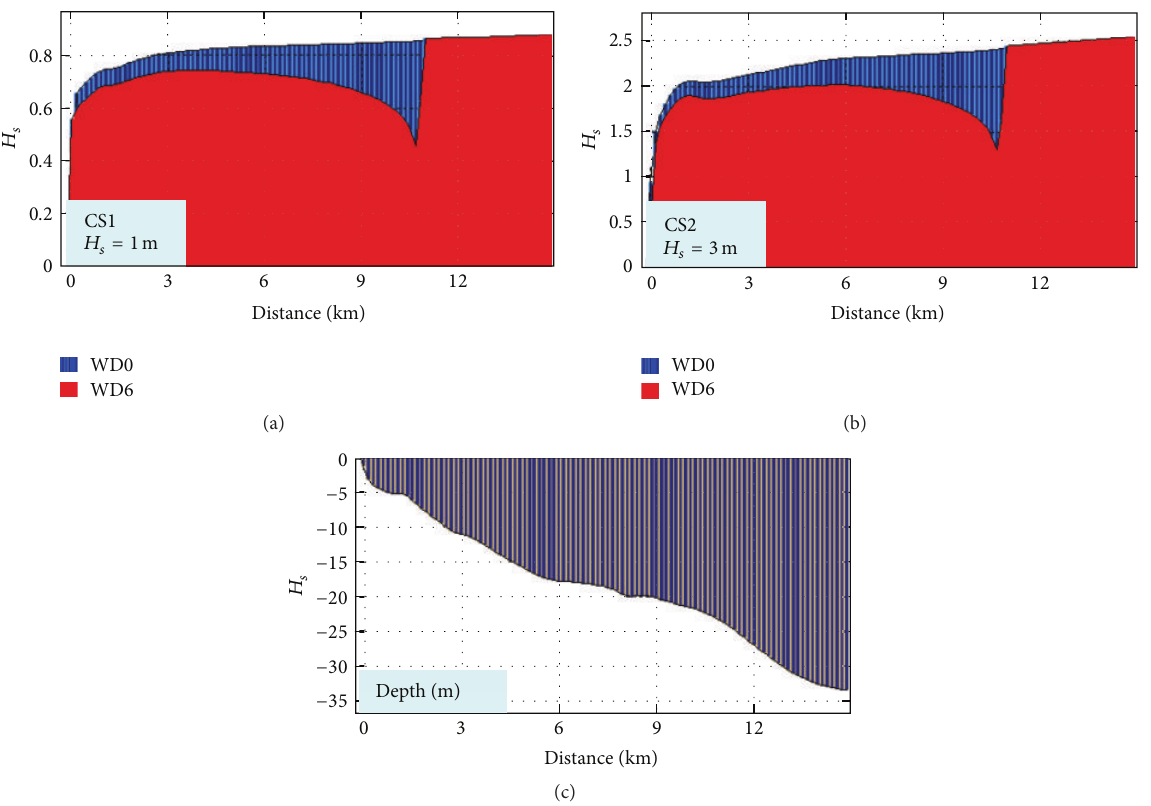
Figure 12: 𝐻 𝑠 variation along the reference line 1 without and with WD farm (WD0, WD6) for the two cases considered (CS1, CS2) and the variation of the water depth along the reference